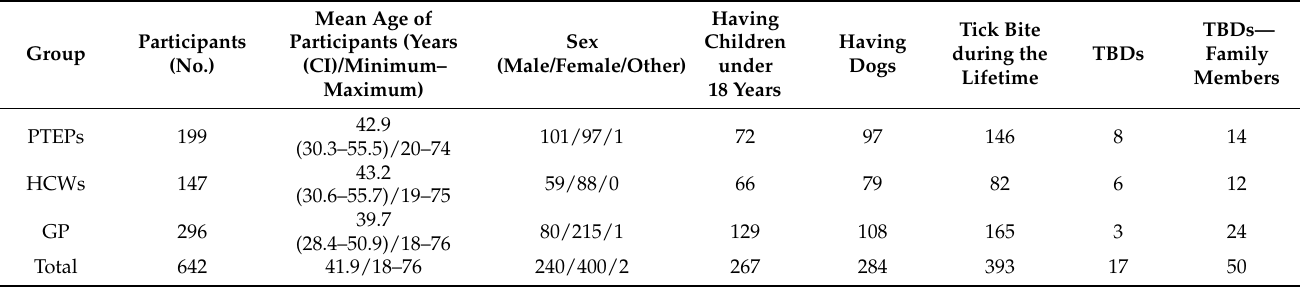
Table 1. Results of the tested parameters of the three groups of participants in terms of knowledge, attitudes, and practices in